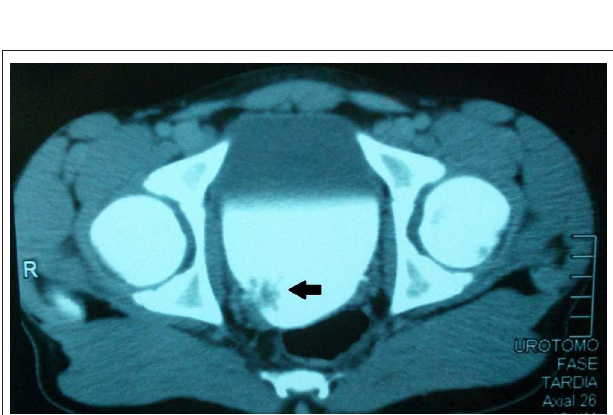
FIGURE 1 | Abdominal MRI, in axial section, showing the lesion (indicated by the white arrow) restricted to the bladder mucosa, close to the right ureteral ostium.